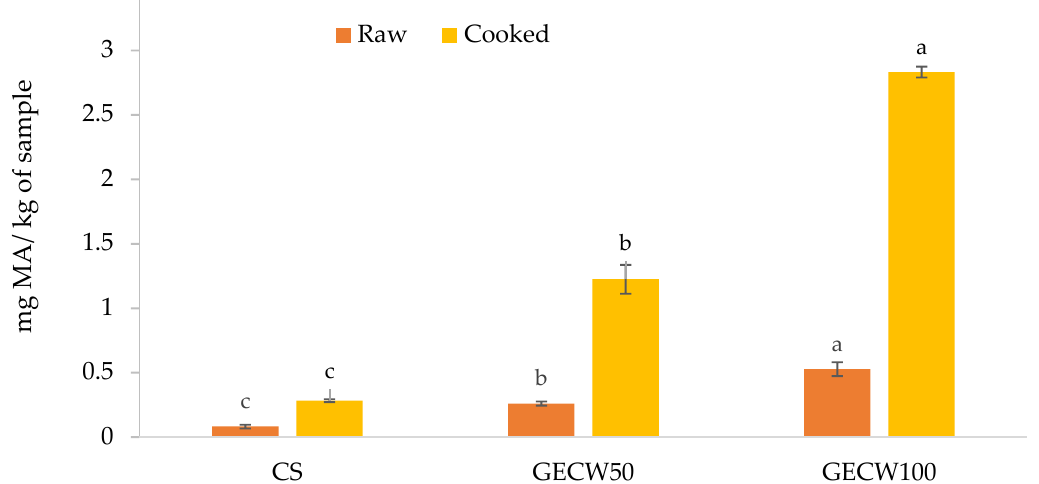
Figure 5. Lipid oxidation values of raw and cooked beef burger elaborated with cocoa bean shell flour and walnut oil emulsion gel as partial and total pork backfat replacers. CS: control sample elaborated with the traditional formula; GECW50: sample with 50% gelled emulsion elaborated with cocoa bean shell flour and walnut oil as fat replacer; GECW100: sample with 100% gelled emulsion elaborated with cocoa bean shell flour and walnut oil as fat replacer. For raw or cooked samples bars with the same letter are not significantly different ( p > 0.05) according to Tukey’s multiple range test.